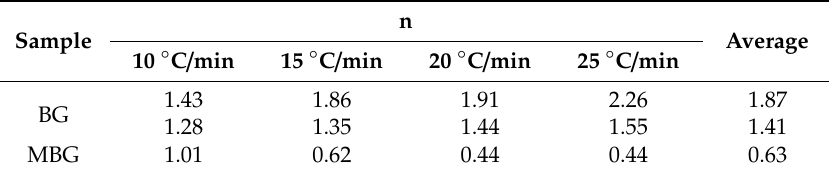
Table 7. Crystal growth index (n) of the BG and